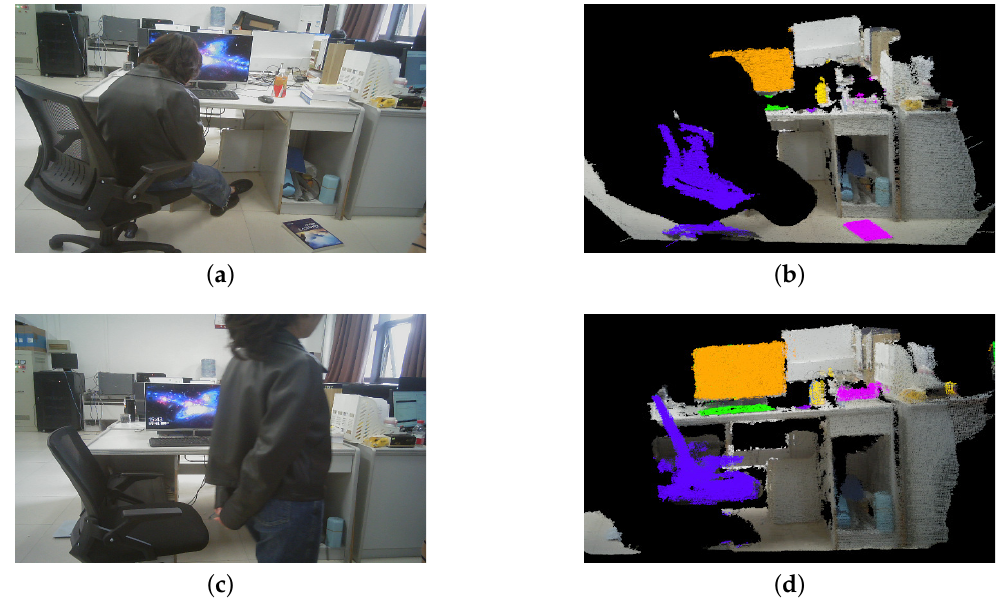
Figure 11. Static Semantic Map of Real Scene: ( a ) a frame in low dynamic scene; ( b ) our algorithm results in a low dynamic scene; ( c ) a frame in a high dynamic scene; ( d ) our algorithm results in a high dynamic